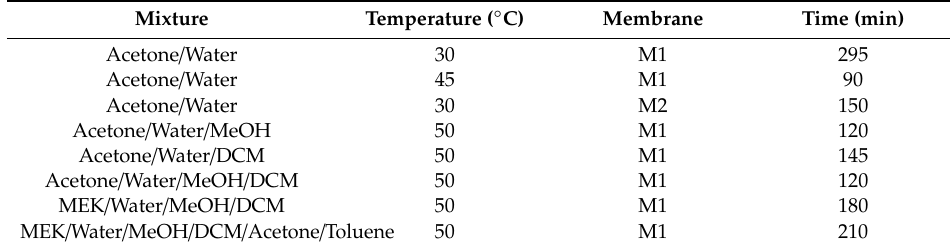
Figure 12. Evolution of flux as the function of the inlet water composition from a multi-component MEK-water–MeOH-DCM-acetone-toluene mixture (90/2.0/2.0/2.0/2.0/2.0 wt%) through M1 at 50 °C.